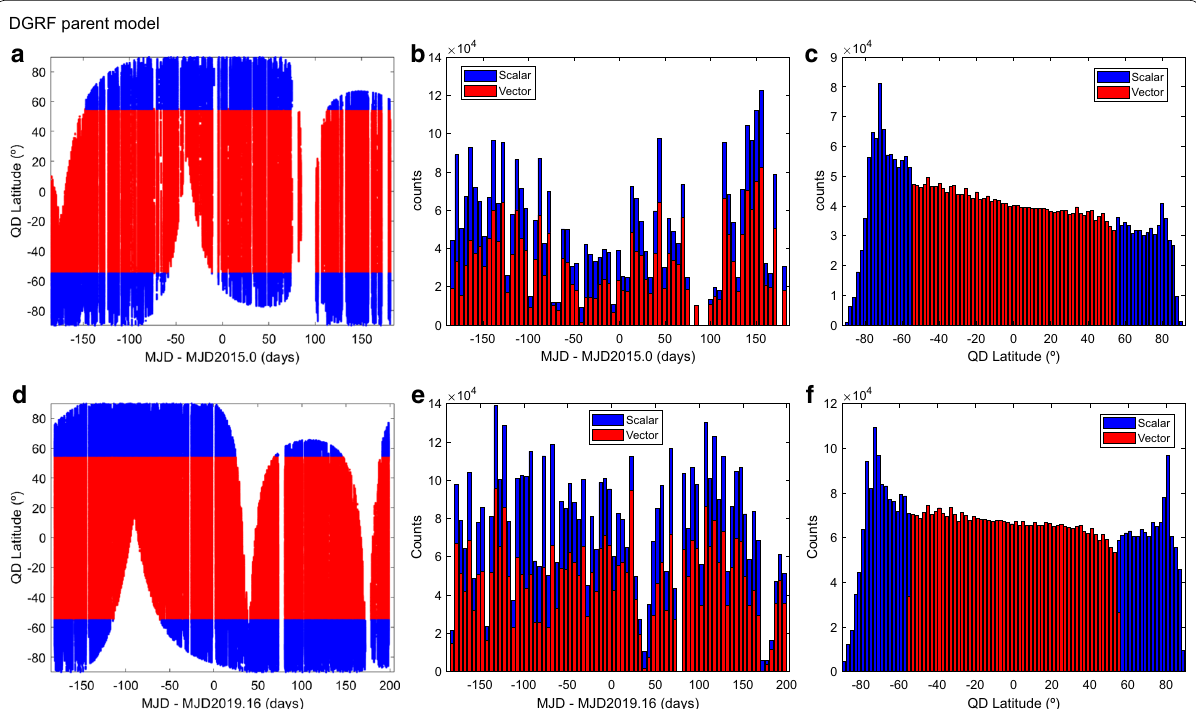
Fig. 1 a , d Spatial distributions of Swarm A data according to the quasi‑dipole latitude and time in modified Julian days. b , e Temporal histograms of the number of data (scalar and vector) using bins 5 days wide. c , f Number of Swarm A data as a function of the quasi‑dipole latitude (bins every 2°). Upper panel: Swarm A data for DGRF parent model and modified Julian days relative to 2015.0. Lower panel: Swarm A data for IGRF parent model and modified Julian days relative to